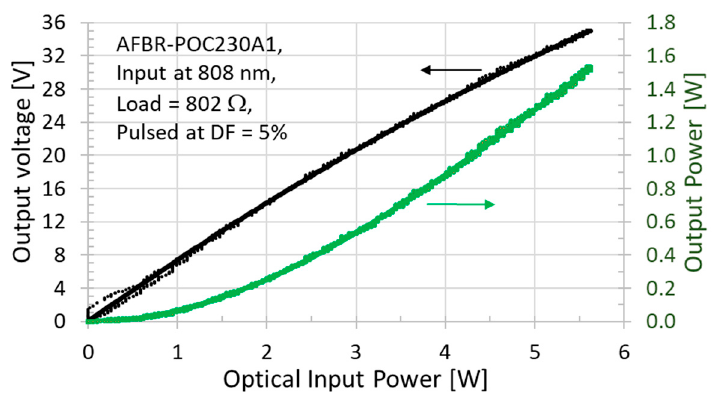
Figure 8. Regular ‐ power PT30 (Broadcom’s AFBR ‐ POC230A1) in pulsed mode at 808 nm with duty ‐ factor of DF = 5% in a fixed external load of 802 Ohms. The device area is 0.03 cm 2 , giving an averaged optical intensity of 170 W/cm 2 at 5.5 W.